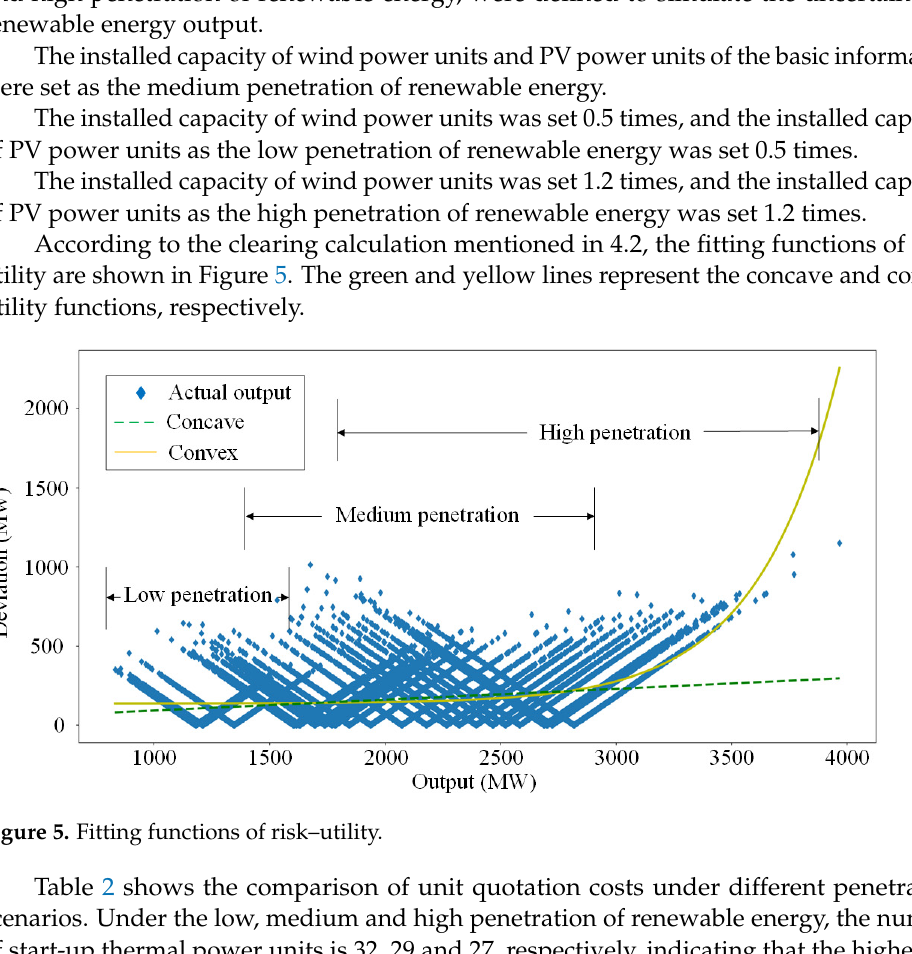
Table 2. Comparison of units quotation cost under different penetration